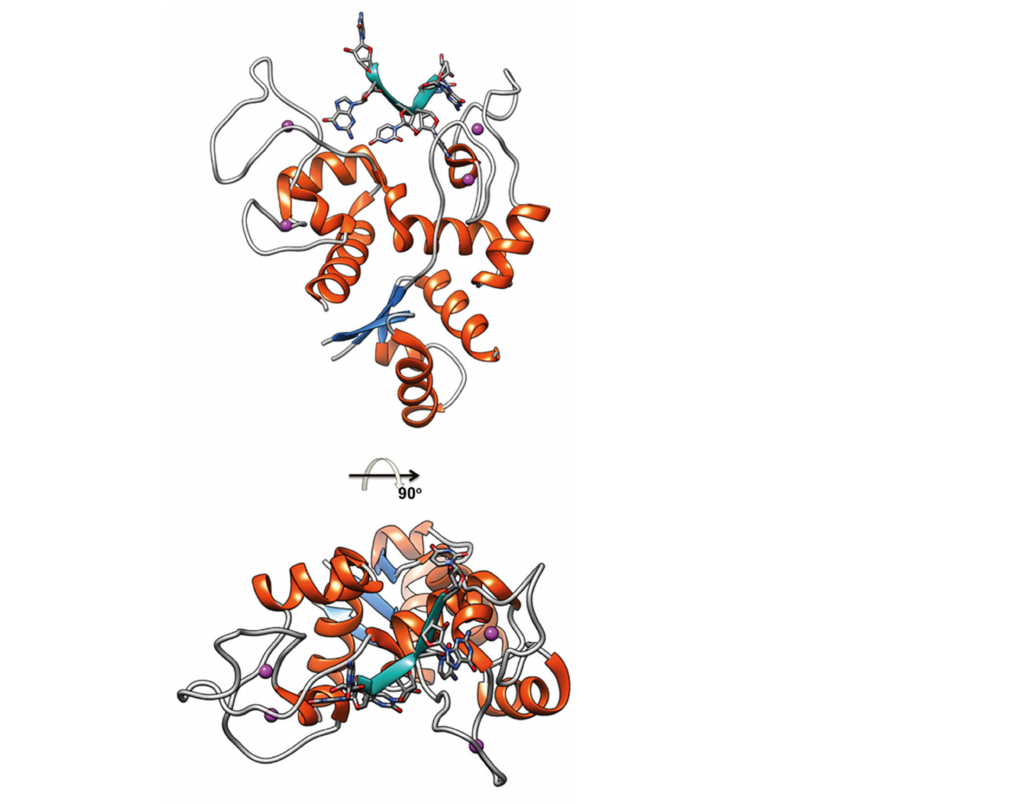
Figure 3. ZAP N-terminal domain binding a CG-rich single strand of RNA; CG dinucleotide is the key element targeted by ZAP (PDB code